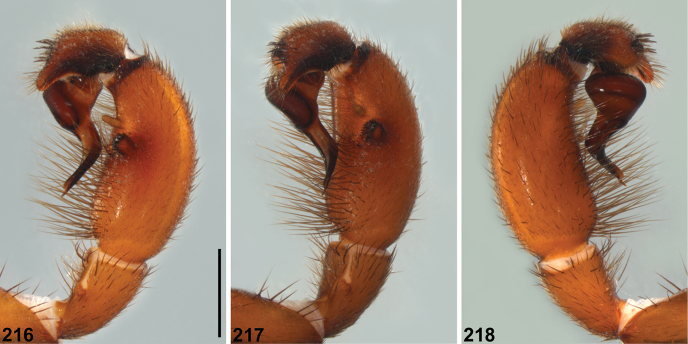

Idiosoma
intermedium sp. n., male holotype (WAM T139520) from Bodallin (Western Australia’ AVW), pedipalp. 216 Retrolateral view 217 Retroventral view 218 Prolateral view. Scale bar 2.0.